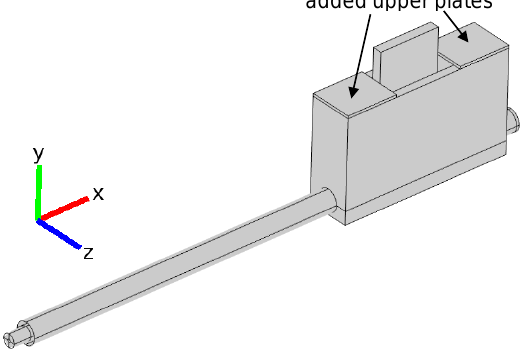
Figure 10. 3D model of the MPSS with two upper metal plates added (semi-closed configuration).